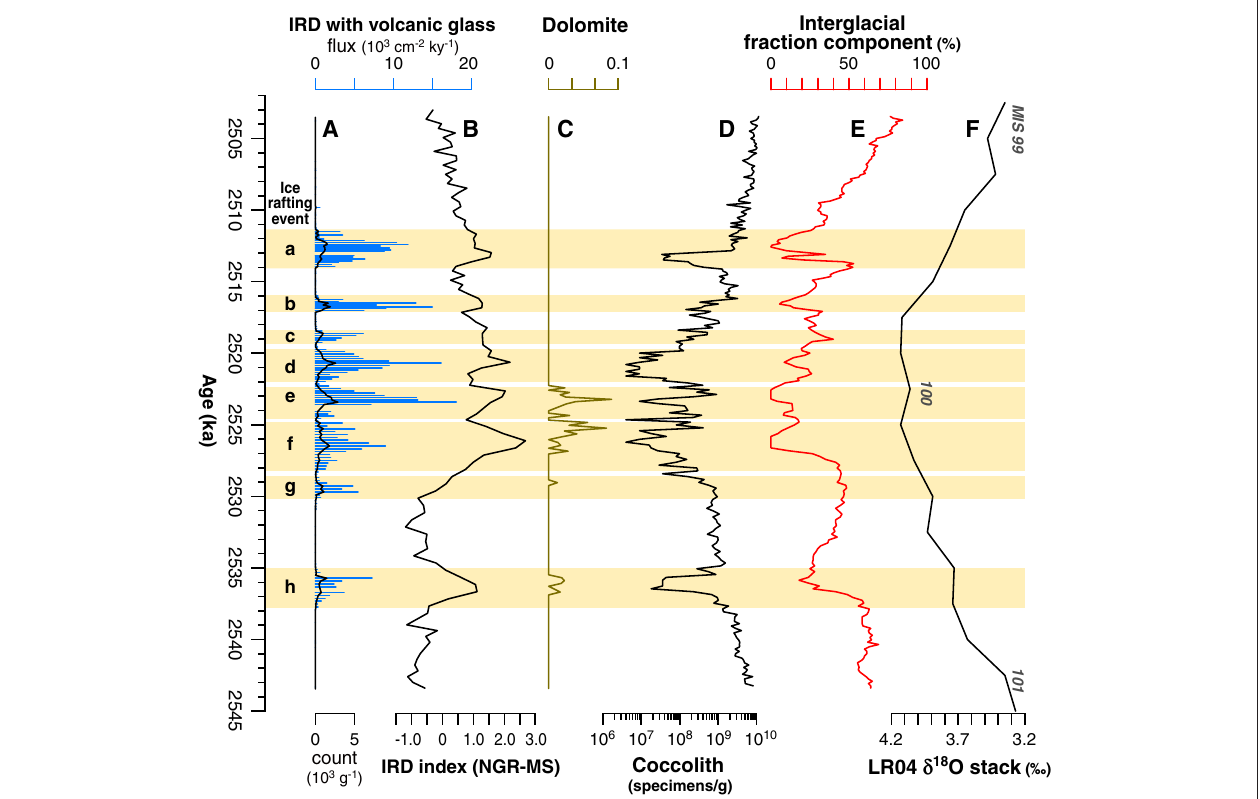
FIGURE 6 | Summary of paleoceanographic records during the MIS 100 glacial period from IODP Site U1314. (A,B) , and (C) Ice-rafting events; (D) ocean surface condition; (E) bottom current variability; (F) Global ice volume (LR04 stack: Lisiecki and Raymo, 2005; see text).